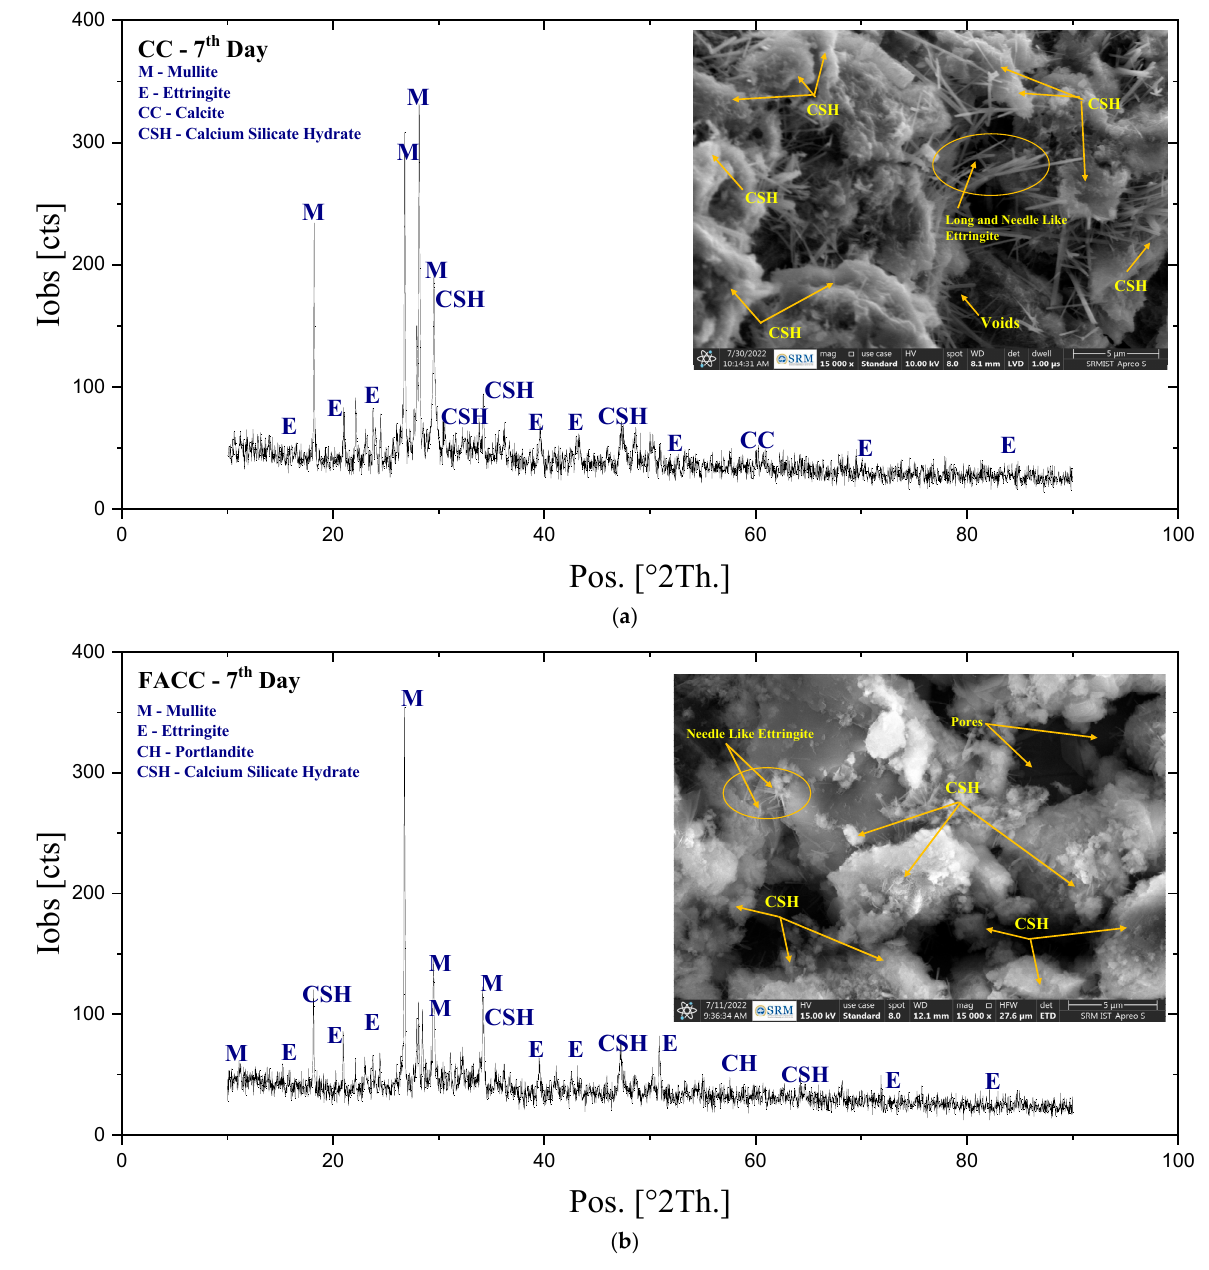
Figure 11. XRD and SEM ( a ) CC ( b ) FACC on the Seventh Day of Testing. Using X-pert High Score Pus software, the XRD analysis at angles of 0–90-degrees was carried out, which can be seen in Figures 10–13 for both CC and FACC at the 1st, 7th, 14th, and 28th day of testing. The samples confirm the presence of different hydrated phases, such as Calcium Silicate Hydrate (CSH), Calcium Aluminium Silicate Hydrate (CASH), Ettringites, Mullite (M), Calcium Hydrate (CH) and traces of Calcite (CC). The peak intensity of different phases was predominant in CC as compared to the FACC mixes. The main crystalline peaks observed are CSH phase, with slightly weaker peaks of ettringites. This confirms that the systematic hydration of the cement paste was carried out. When compared to CC, the peak intensity value did not substantially vary from the FACC mix (the peak intensity varied in the range of 200–400 counts). With the development of the curing period, the hydration phase could be observed in both FACC and CC,